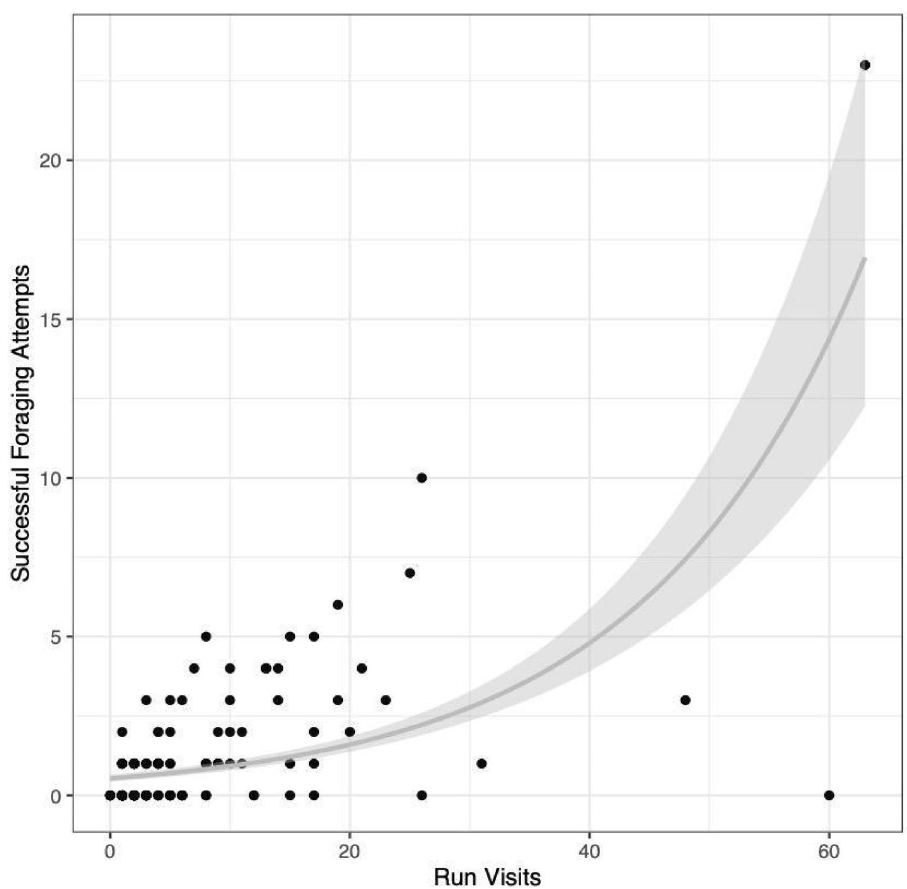
Figure 3. Total successful foraging events relative to run visits for each individual harbor seal (n = 170). The line represents a Generalized Linear Model (GLM) of successes by run visits with a Poisson distribution (adjusted R 2 = 0.36) and 95% confidence interval based on standard